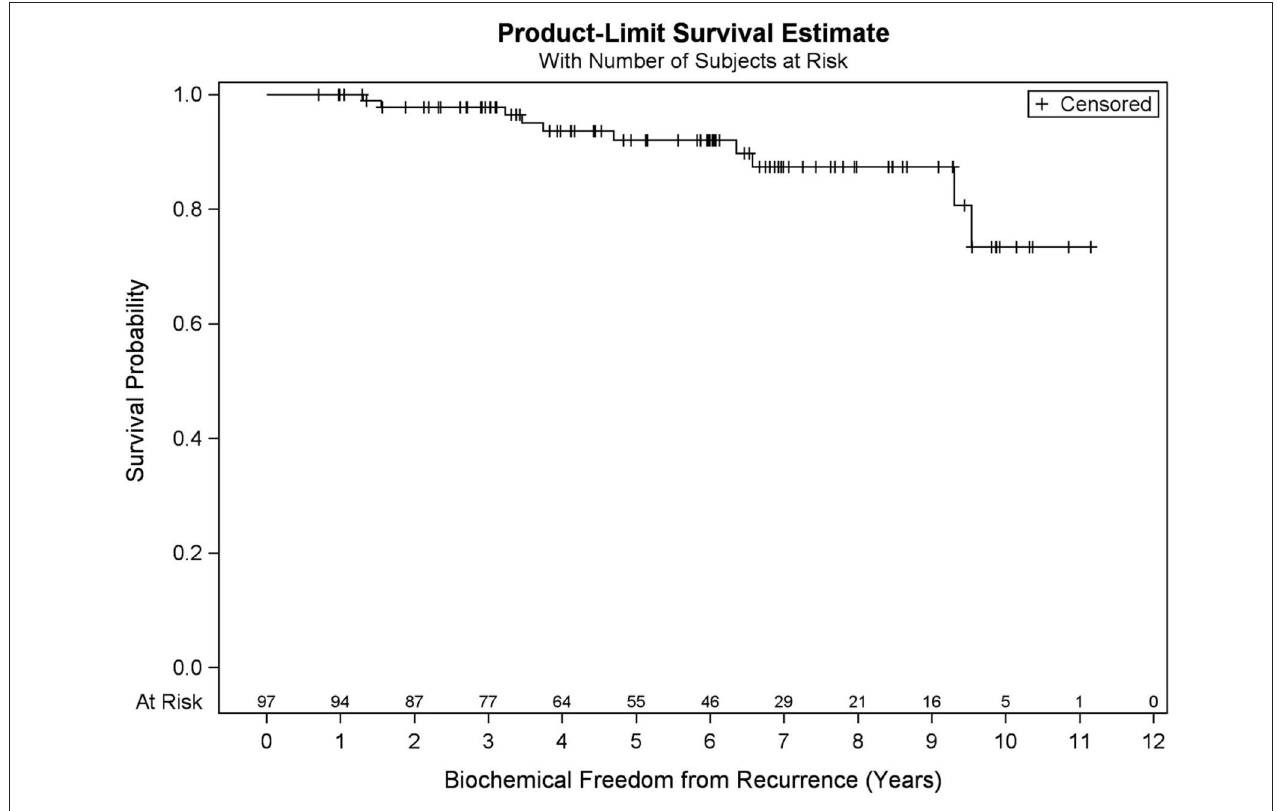
FIGURE 3 | Kaplan–Meier curves for biochemical freedom from recurrence in all patients ( N = 97).